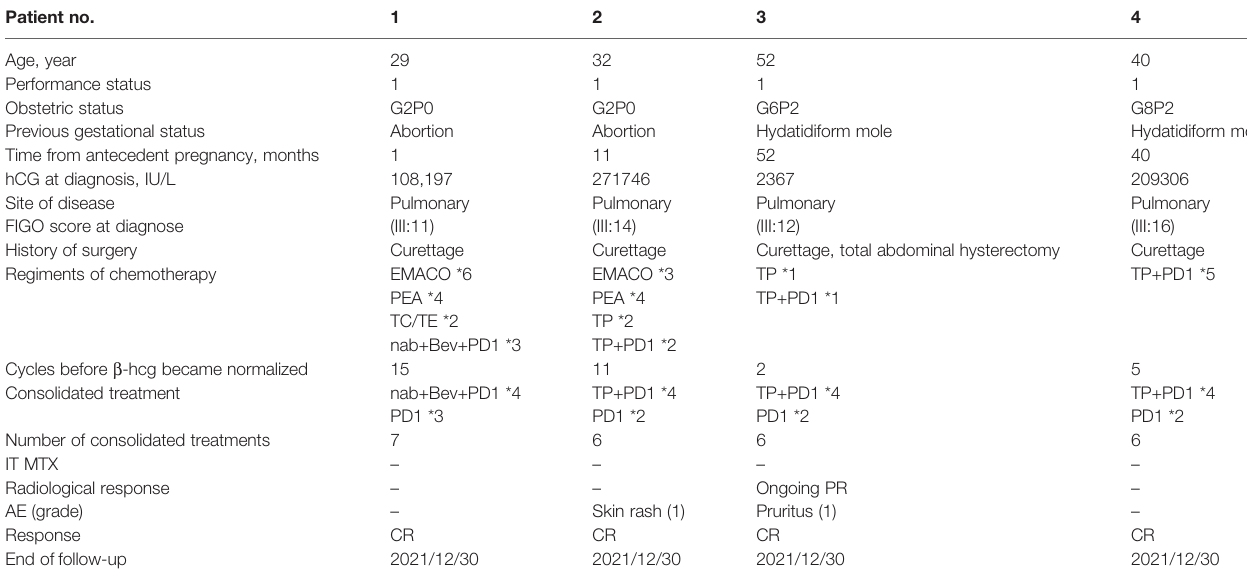
TABLE 1 | Patient characteristics. Patient no.